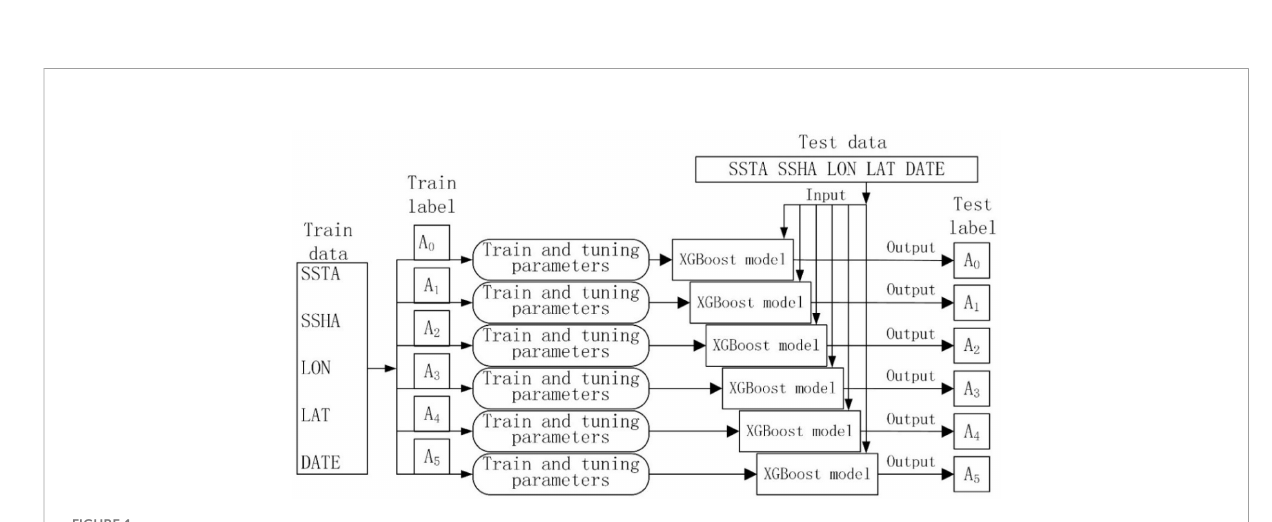
FIGURE 1 Flow chart of the XGBoost model training and